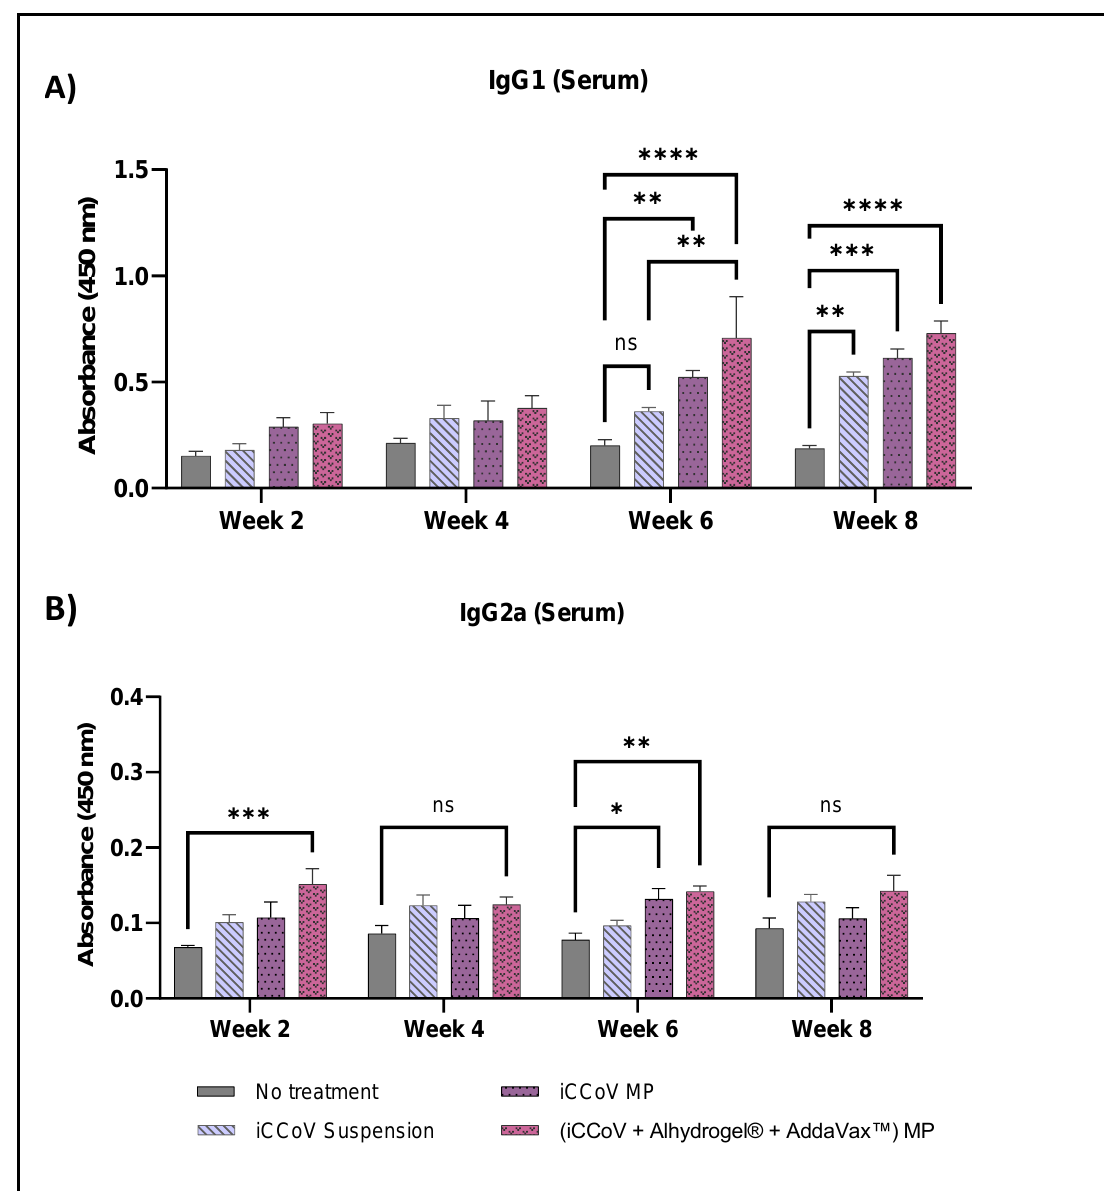
Figure 11. Assessment of serum IgG1 and IgG2a antibody levels in mice. Serum IgG1 Levels ( A ) and serum IgG2a levels ( B ). (Absorbance at 450 nm). Responses obtained are compared to the naïve group (No treatment control) and the iCCoV suspension group. Data are expressed as mean ± SEM, n = 4 mice, Two-way ANOVA, Post hoc Tukey’s multiple comparisons test. ns, non-significant, * p ≤ 0.05, ** p ≤ 0.01, *** p ≤ 0.001, **** p ≤ 0.0001.